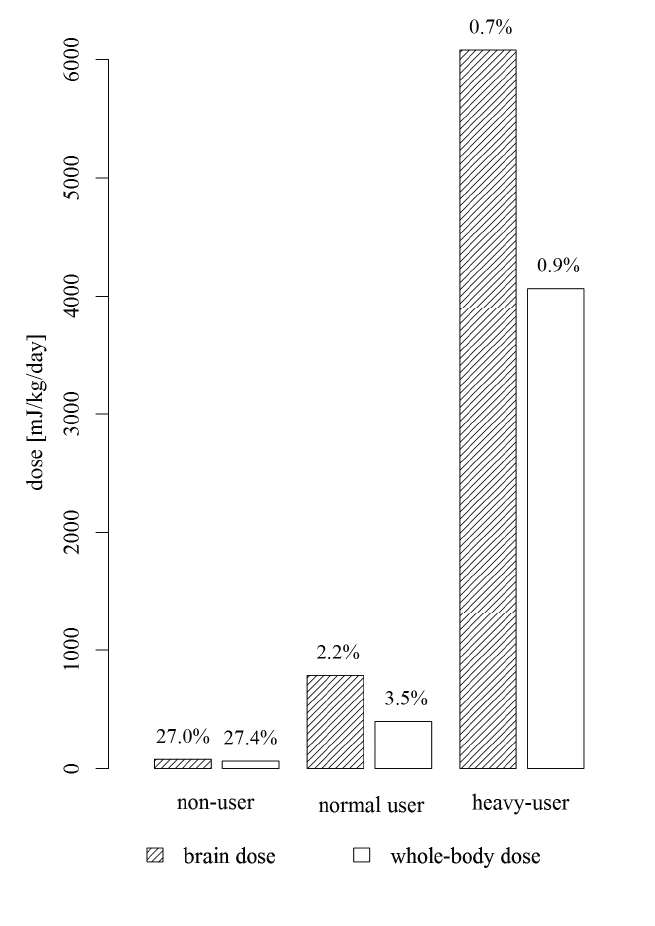
Figure 3. Total brain and whole-body dose for the three HERMES study participants (non-user, normal user, heavy-user); Percentages of the far-field dose on the total dose are indicated above the